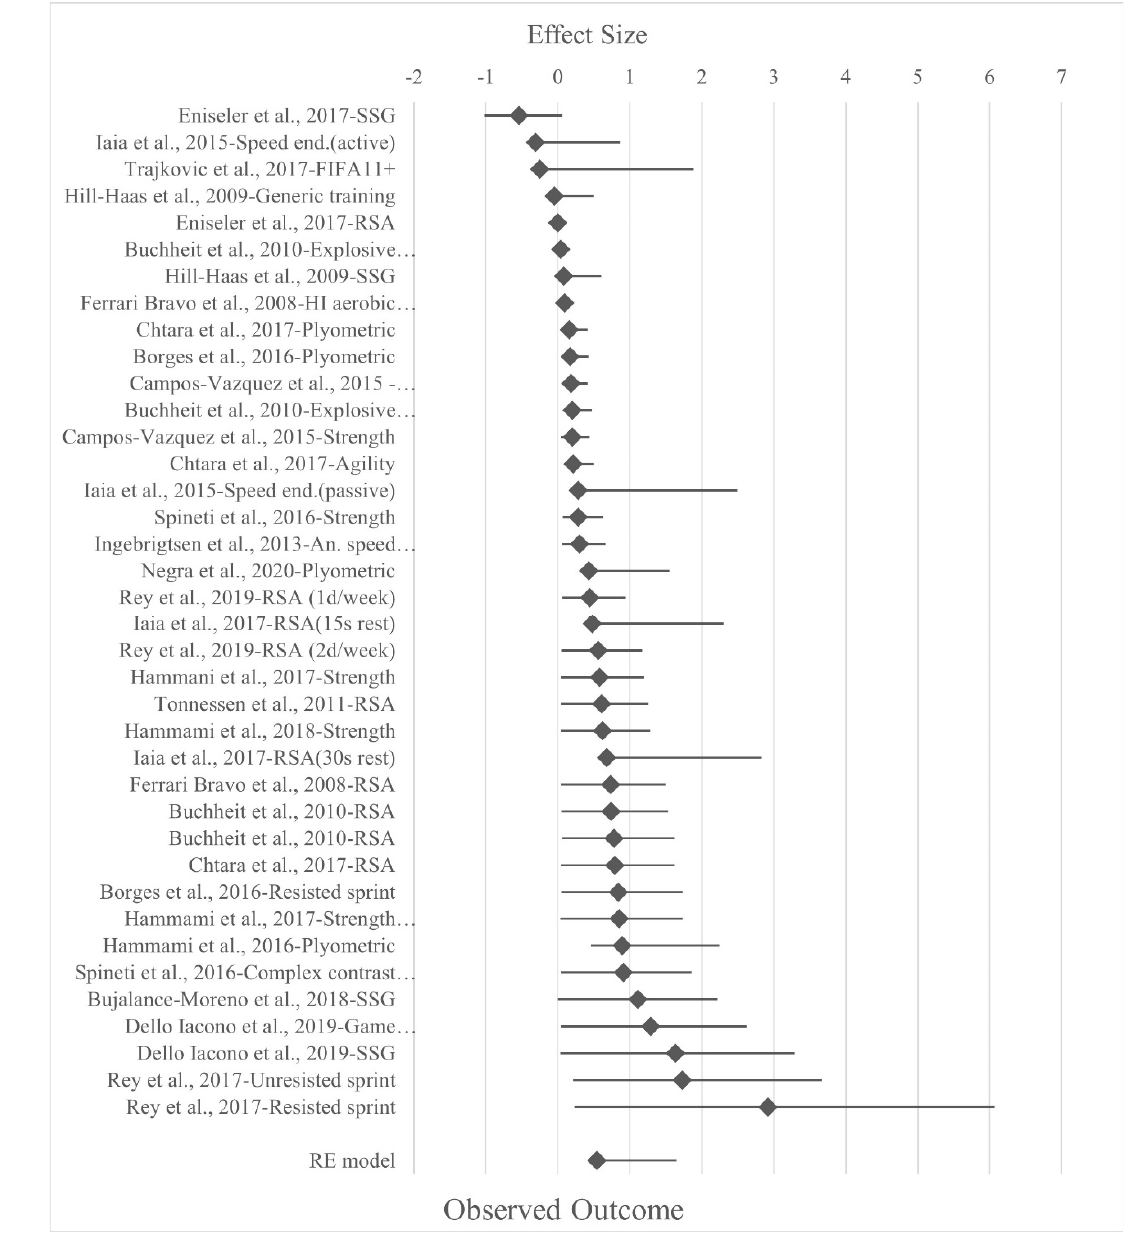
Figure 2. Effects of different training programs on RSA of soccer players.